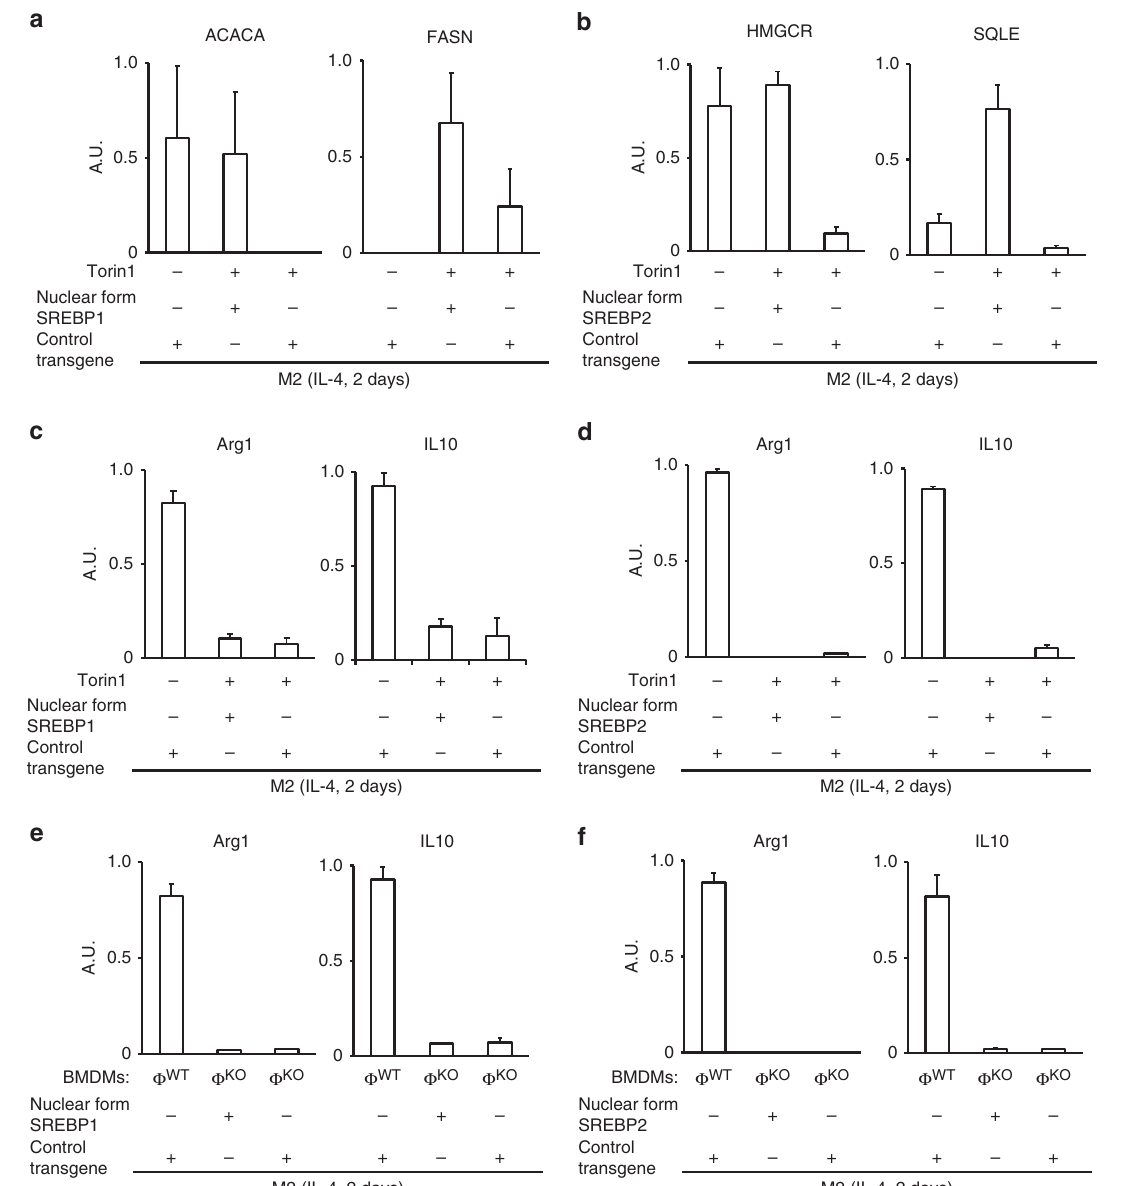
Figure 8 | SREBPs are not involved in M2 polarization of macrophages. ( a ) Real-time PCR for SREBP1 (cid:2) target genes in IL-4 (cid:2) stimulated BMDMs. Nuclear form SREBP1 gene was introduced to wild-type BMDMs with retroviral vector. ( b ) Real-time PCR for SREBP2 (cid:2) target genes in IL-4 (cid:2) stimulated BMDMs. Nuclear form SREBP2 gene was introduced to wild-type BMDMs with retroviral vector. ( c ) Real-time PCR showed that forced expression of nuclear form SREBP1 did not rescue M2 polarization of mTOR-inhibited wild-type BMDMs. ( d ) Real-time PCR showed that forced expression of nuclear form SREBP2 did not rescue M2 polarization of mTOR-inhibited wild-type BMDMs. ( e ) Real-time PCR showed that forced expression of nuclear form SREBP1 did not rescue M2 polarization of Lamtor1-deficient BMDMs. ( f ) Real-time PCR showed that forced expression of nuclear form SREBP2 did not rescue M2 polarization of Lamtor1-deficient BMDMs. F WT and F KO are defined as in Fig. 1. The retroviral control transgene expressed GFP. More detailed information about SREBP1 and SREBP2 gene transduction is described in Method section. Error bars show